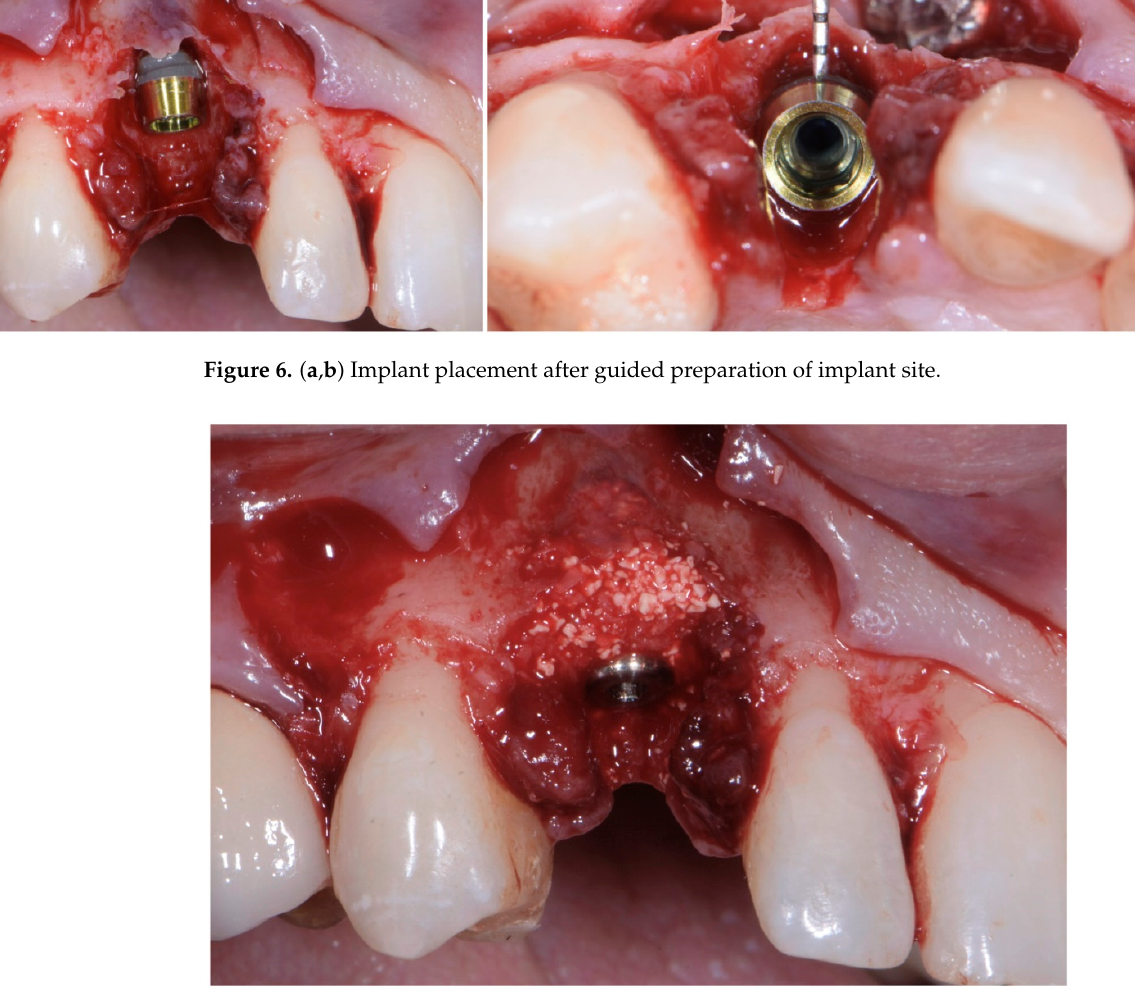
Figure 7. Biomaterial and autologous bone placed to cover the exposed implant threads and to fill the gap between implant surface and socket